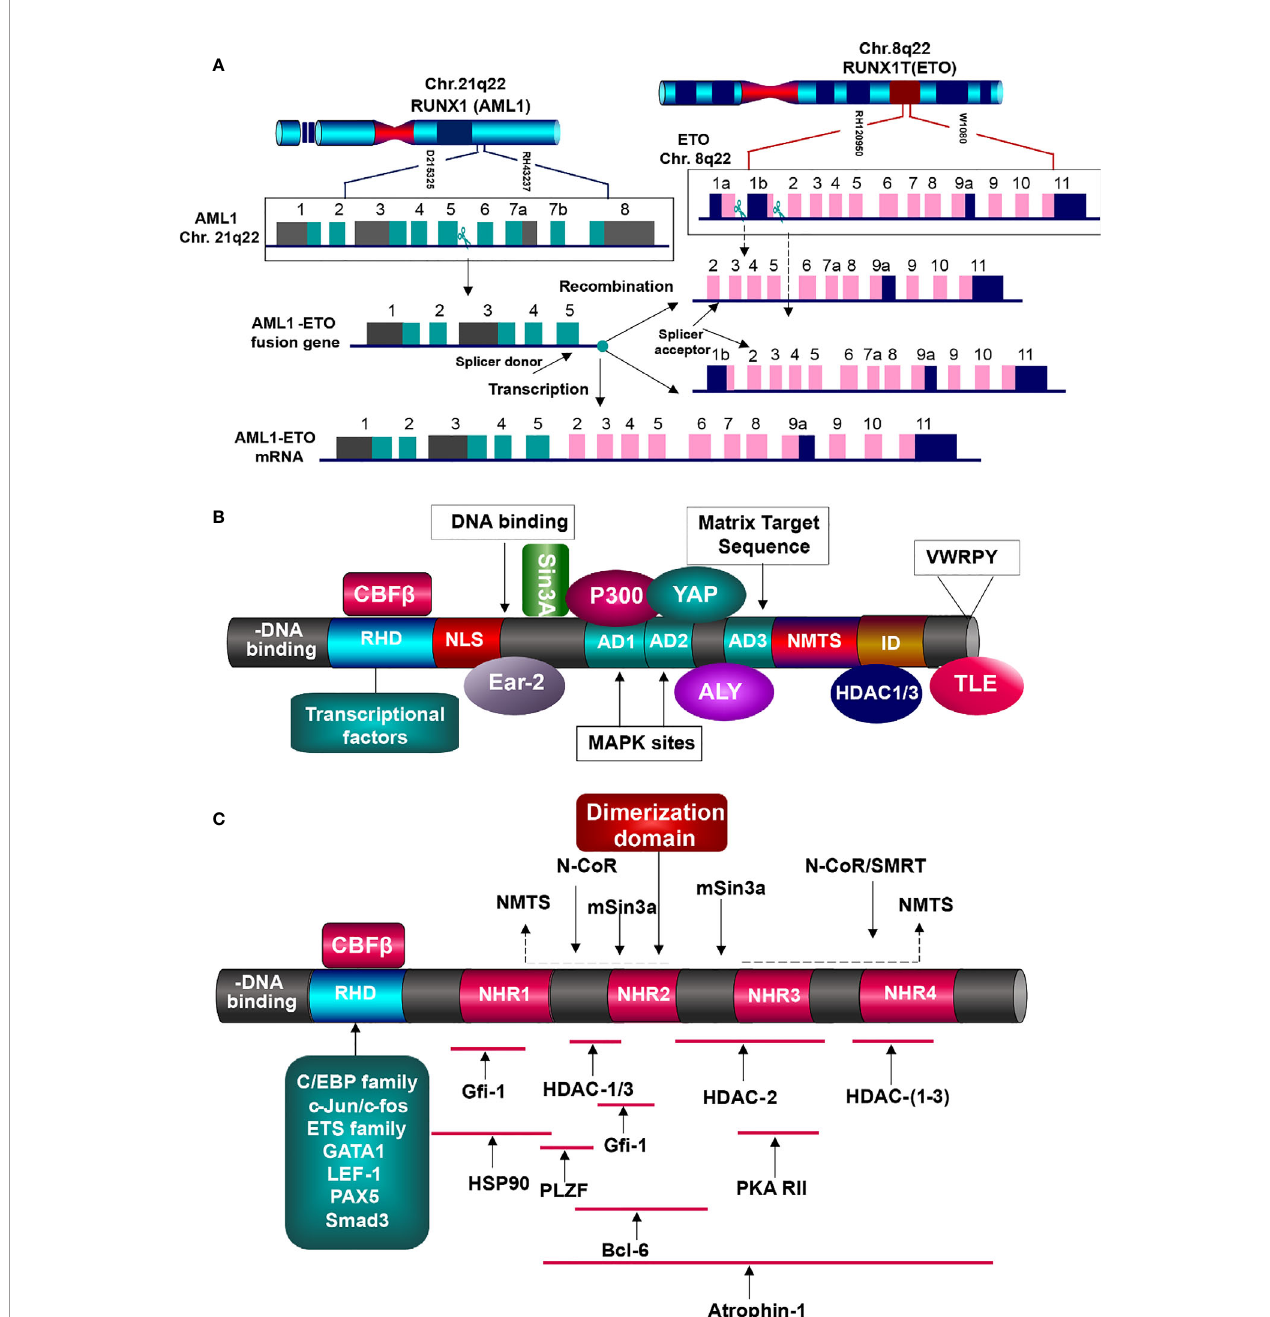
FIGURE 5 | Generation and function of AML1-ETO fusion protein. (A) Generation of AML1-ETO. ETO gene on Chr.8q22 is consist of 13 exons, containing two breakpoints, but one splicer acceptor in exon2. AML1 gene is made up of nine exons with one breakpoint and one splicer donor. Absence of splicer acceptor in exon1b, the two genes generate the only fusion mRNA. (B) AML1 protein structures and partner proteins. AML1 is composed of DNA-binding domain (RHD) and other domains related to signal transduction, transcriptional factors binding, epigenetic modi fi ers interaction, and TLE co-repression, which can interact with HATs (MOZ, CBP, and p300) and HDACs (HDAC1, 2, and 3), resulting in gene activation or inhibition. HATs, histone acetyltransferases; HDACs, histone deaccetylases; RHD, runt homology domain; NLS, nuclear localization signal; AD, activation domain; NMTS, nuclear matrix targeting signal; ID, inhibitory signal; VWRPY sequence. (C) AML1-ETO fusion protein and the interacting partners. AML1 contributes the DNA-binding domain RHD, which binds with various transcription factors, but lacks of domains to elicit regular functions. And nearly whole of ETO structure is involved in the fusion, including the four NHRs. They interat with corepressive complexes, HDACs, and other molecules, initiating the